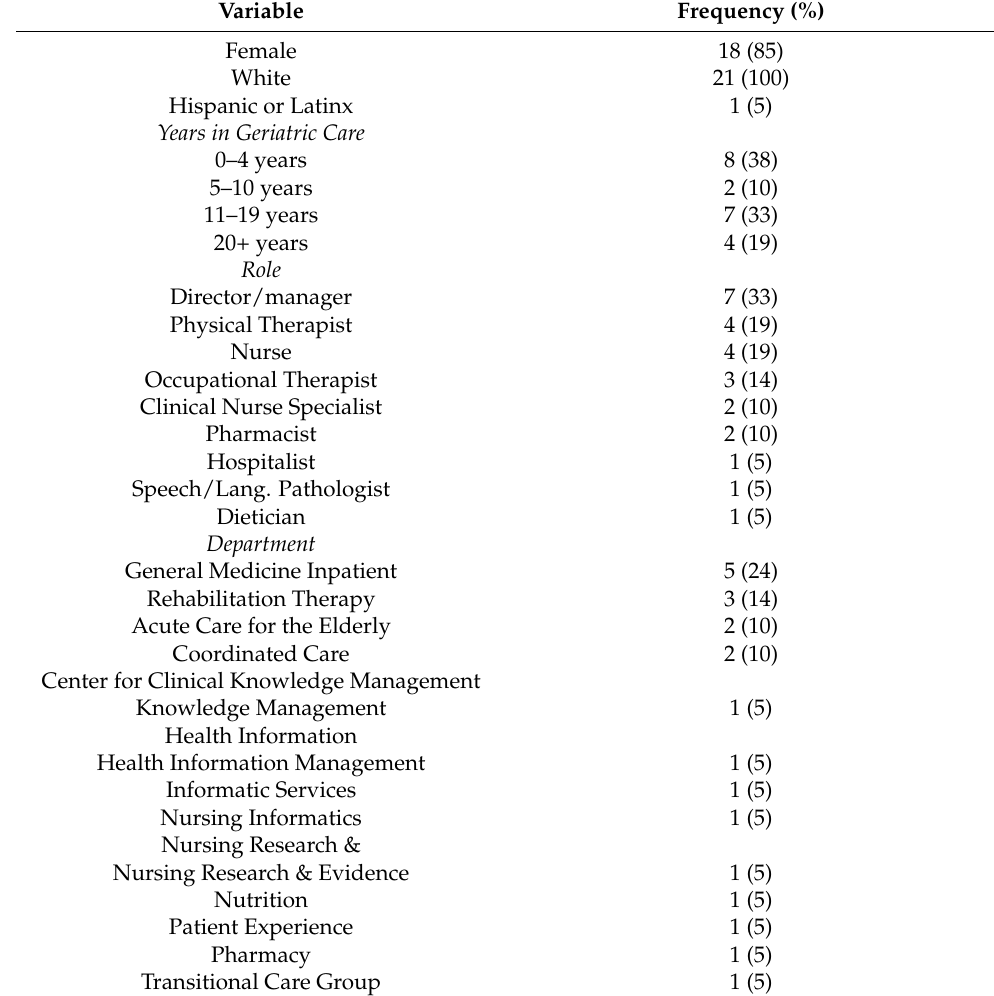
Table 4. Demographic characteristics of healthcare administrators and practitioners ( n =